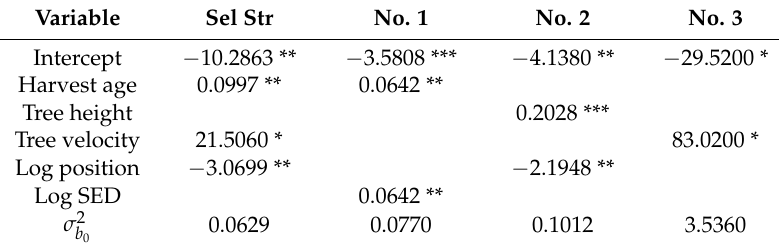
Table 8. Selected parameters and level of significance for lumber structural grade presence/absence models.